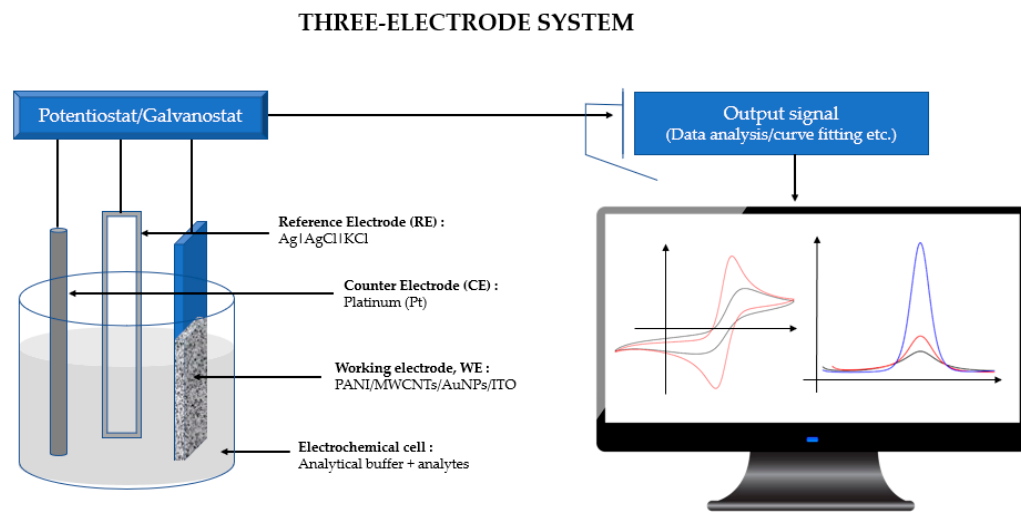
Figure 1. A Computer-controlled potentiostat / galvanostat with a standard three-electrode system connected to an electrochemical cell where Tris-HCl and mercury are used as analytes.